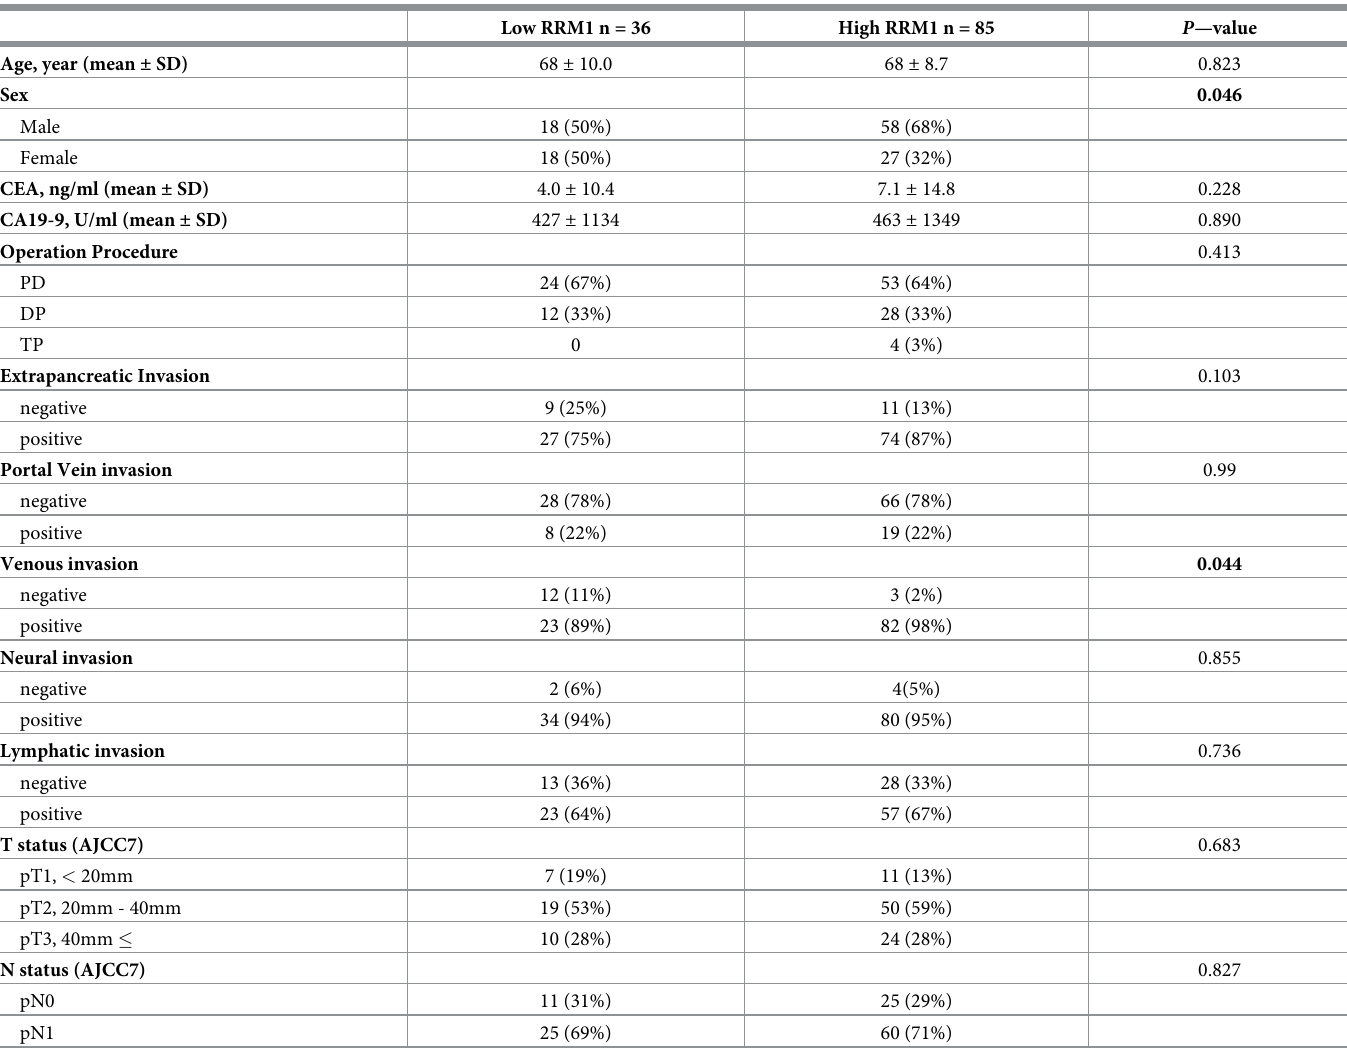
Table 1. Patient